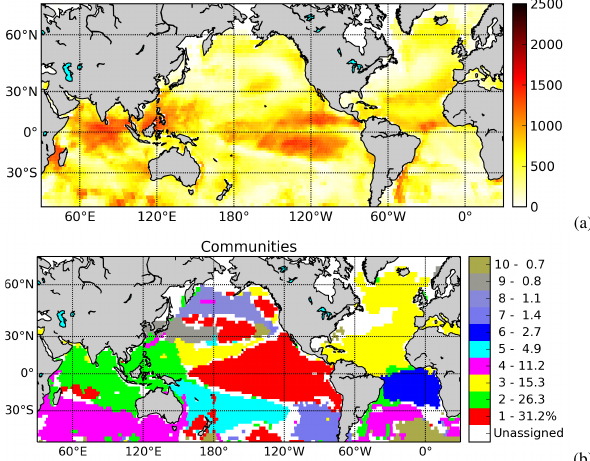
Fig. 6: (a) Degree centrality of the H-SST-LP8y network. The network was built using the same Fig. 6. (a) Degree centrality of the H-SST-LP8y network. The net- work was built using the same methodology as the H-SST network methodology as the H-SST network except that the time series were 8 years low-pass filtered and a except that the time series were 8yr low-pass filtered and a thresh- threshold τ =0 . 6 was used for significance; this results in an edge density ρ =0 . 087 . (b) Filtered old τ = 0 . 6 was used for significance; this results in an edge density communities in the H-SST-LP8y network. ρ = 0 . 087. (b) Filtered communities in the H-SST-LP8y network.